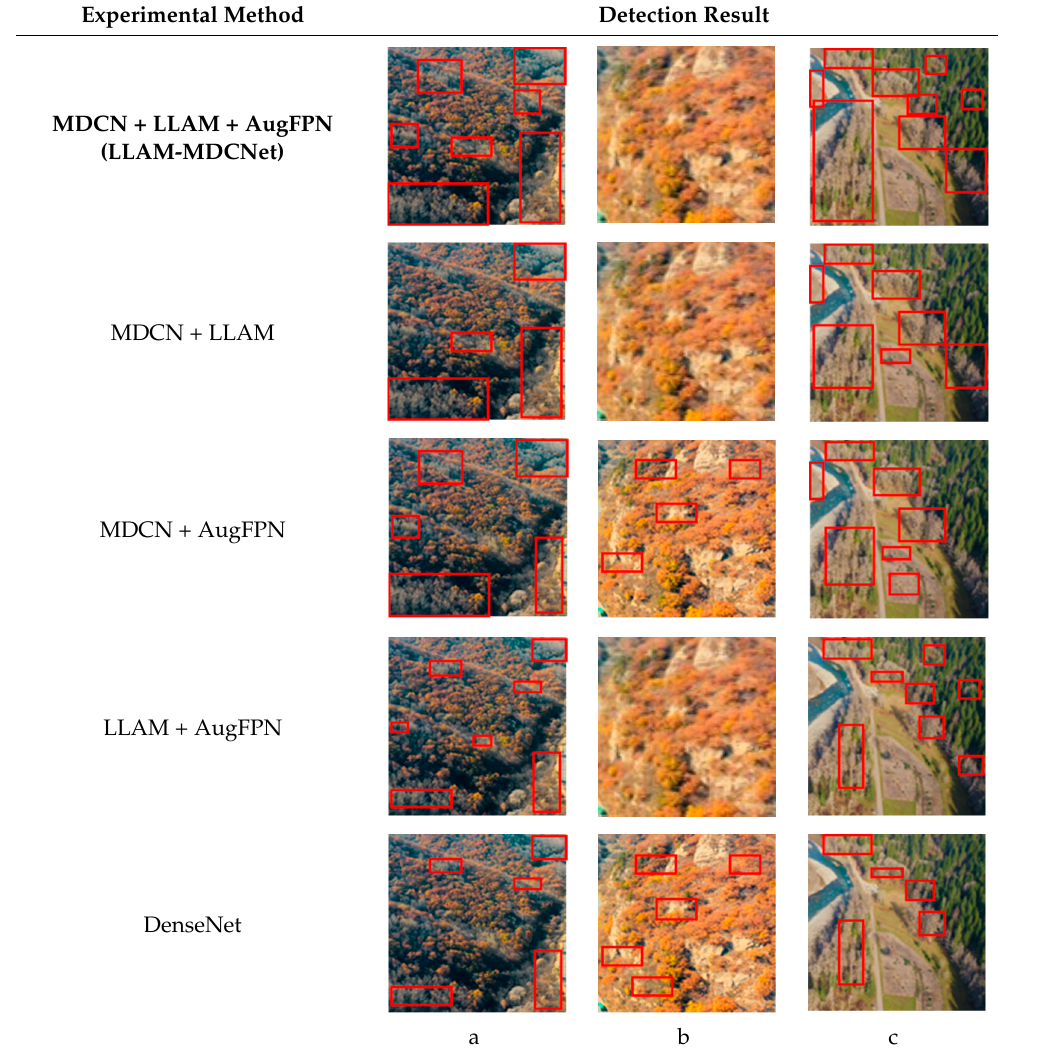
Table 2. Visual comparison of the test results.